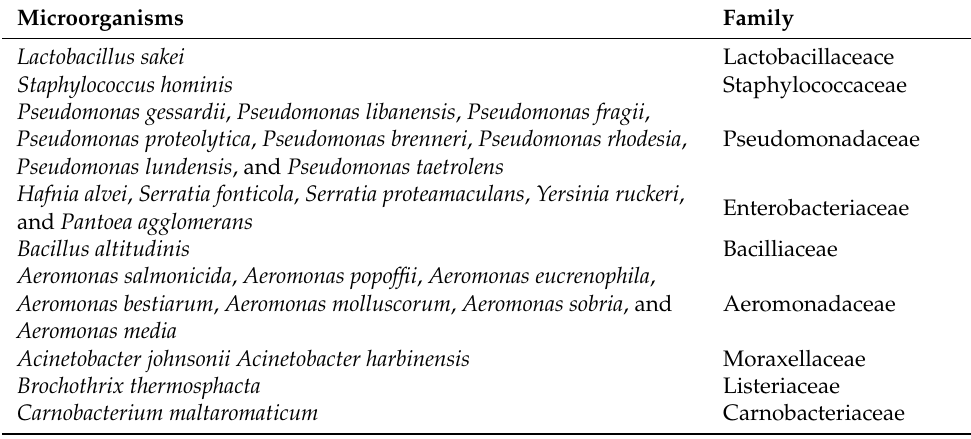
Table 4. Families of isolated microorganisms.